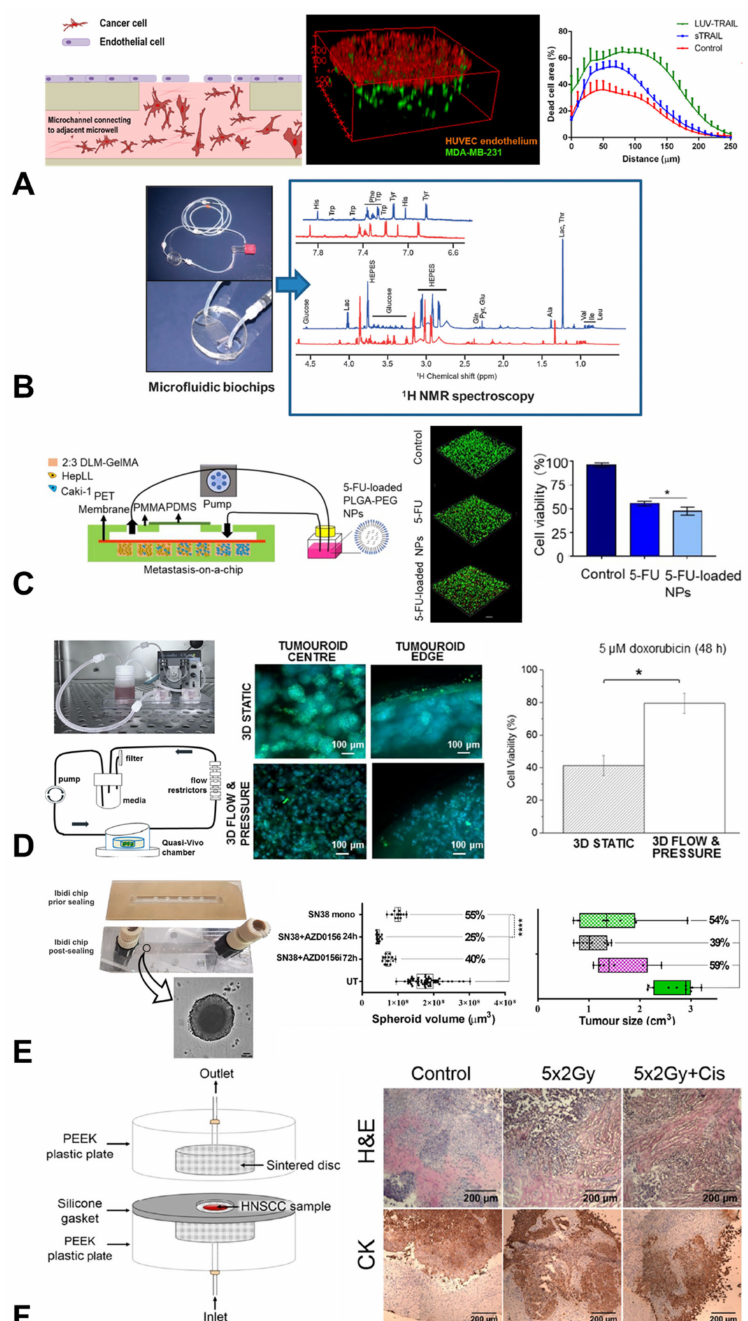
Figure 5. Organ-chip models applied for therapeutic testing in oncological research. ( A ) A chip model to test the delivery of TRAIL treatment to breast tumour cells [50]. ( B ) Organ-chip models of liver